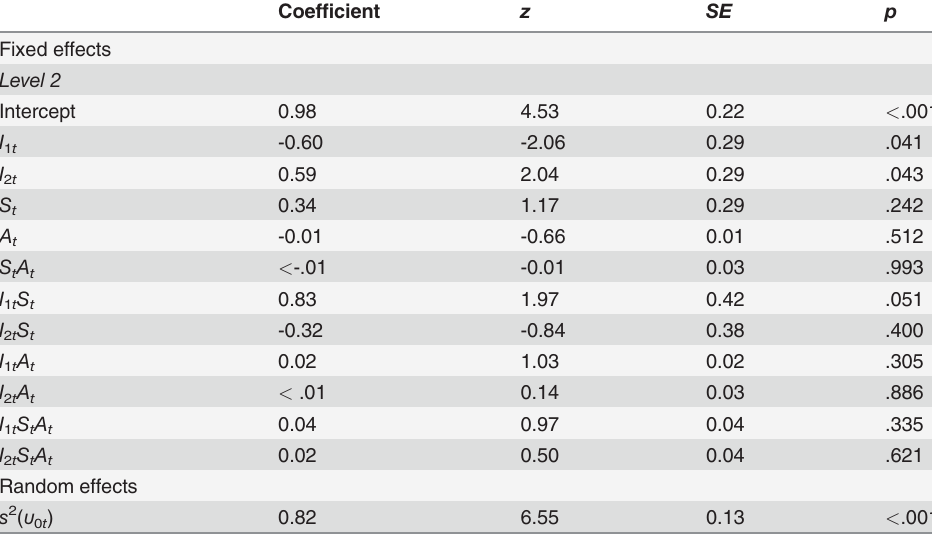
Table 5. Results of Study 1 (Toy-Task).